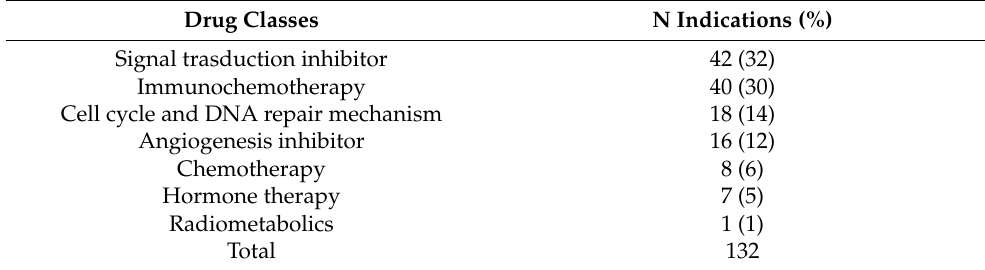
Table 1. Oncologic indications divided for mechanism of